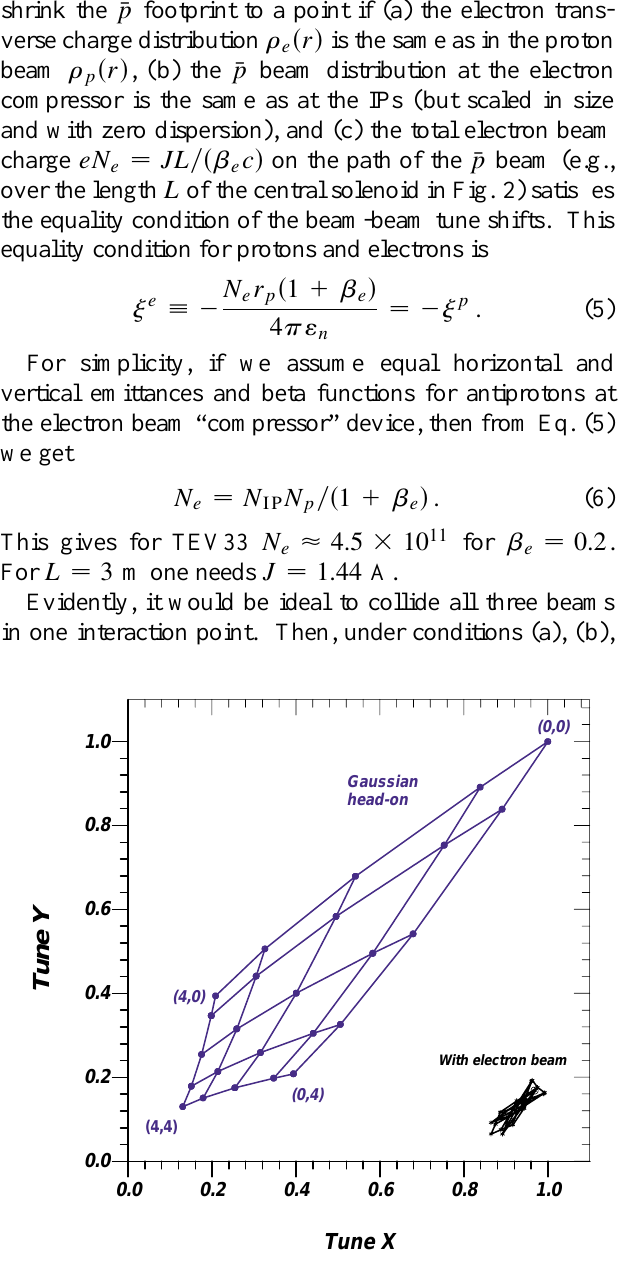
FIG. 6. (Color) Electron compression of the head-on ¯ p foot- print. Tunes are given in units of the head-on beam-beam pa- rameter j p . Numbers in parentheses show the horizontal and vertical betatron amplitudes in units of the rms antiproton beam size. The case with electron beam is displaced for